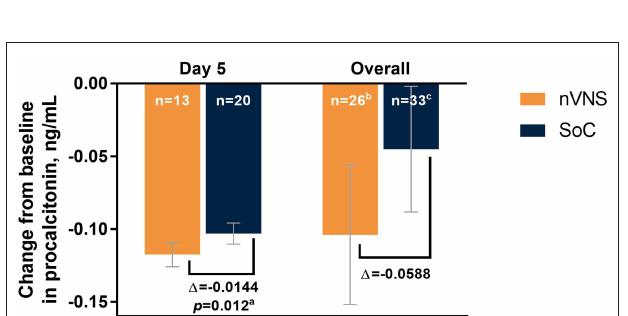
FIGURE 5 | Changes From Baseline in Levels of Procalcitonin by Treatment Group Among Hospitalized Patients With COVID-19. Error bars denote 95% CIs. a p values are from F tests comparing LSM changes from baseline for the nVNS and SoC groups. b 34 observations from 26 participants. c 45 observations from 33 participants. COVID-19, coronavirus disease 2019; LSM, least squares mean; nVNS, non-invasive vagus nerve stimulation; SoC, standard of